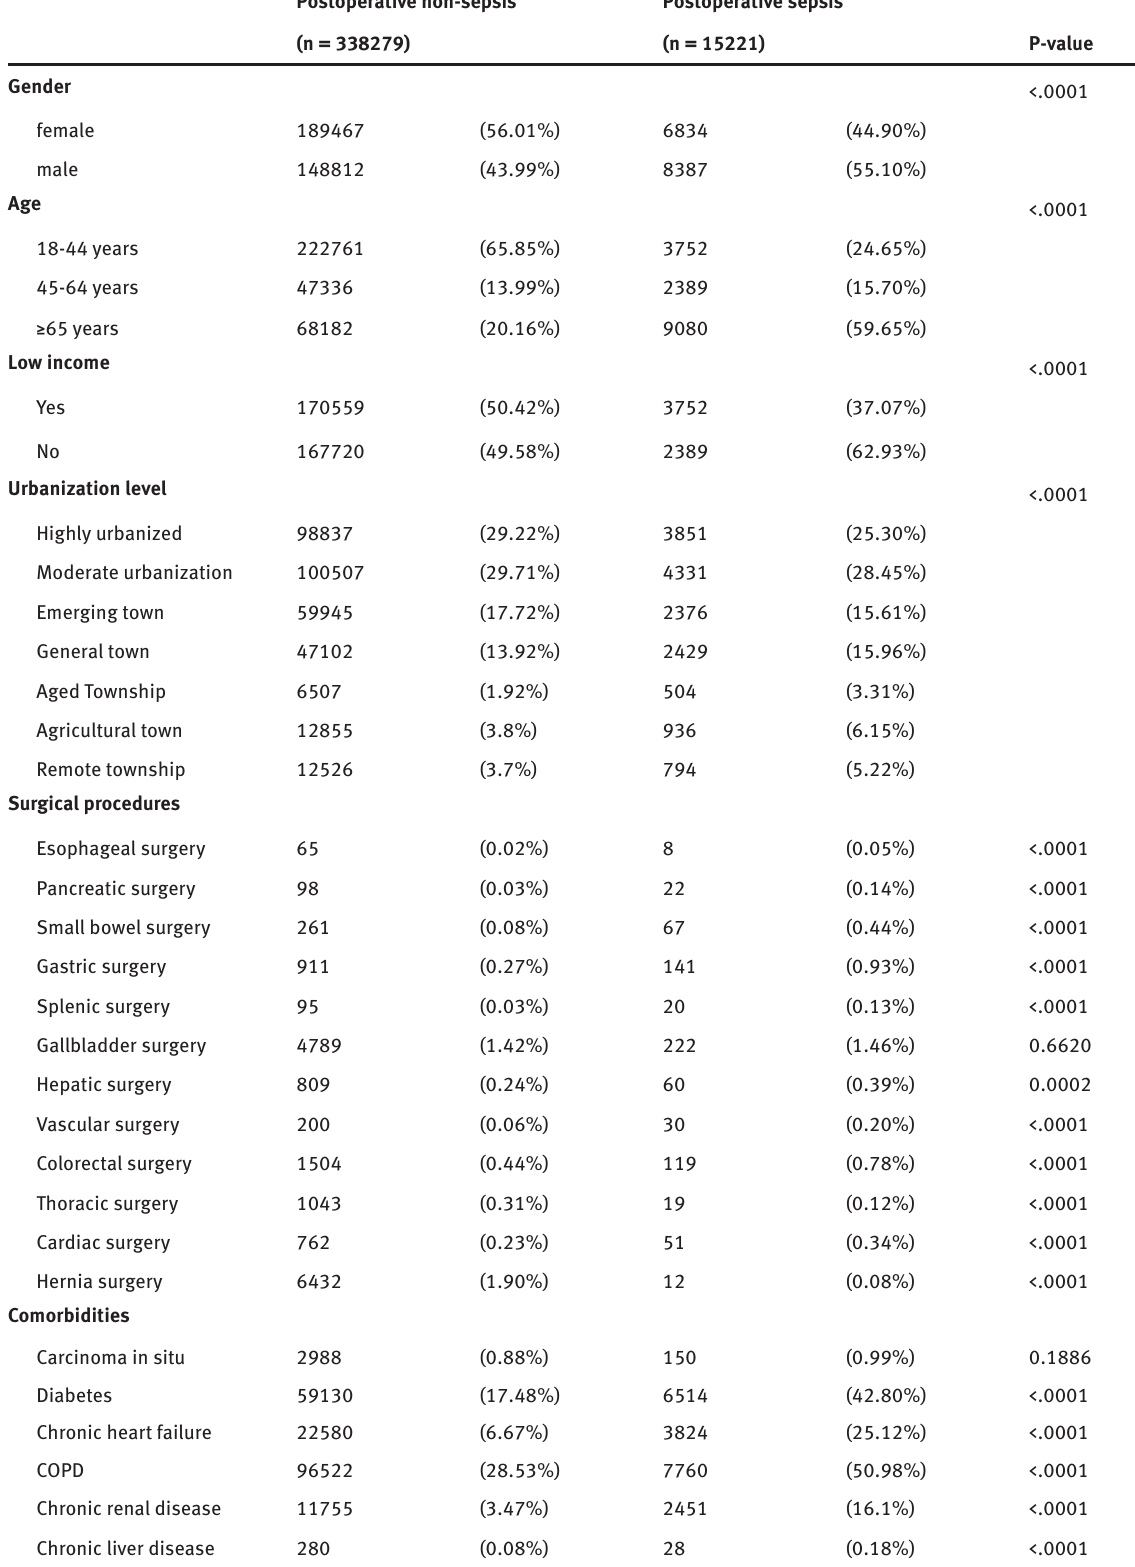
Table 1 : Basic characteristics of the study